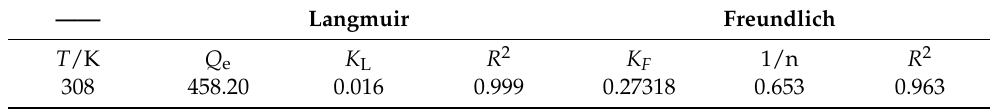
Table 5. Adsorption isothermal model parameters of MGO@ZIF-8 for Cu 2+ . ——